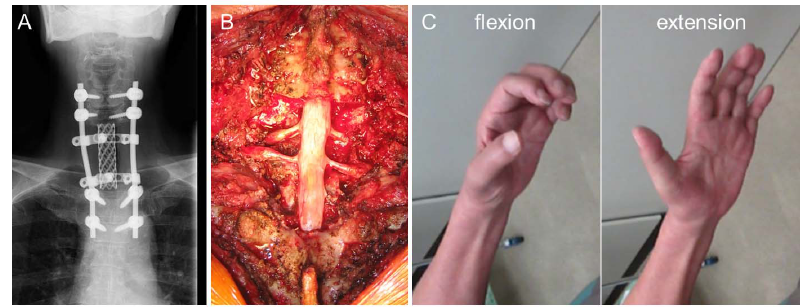
Figure 4. Case 2: A 71-year-old man with metastatic renal cell carcinoma at C7–T2. A: Total en bloc spondylectomy (TES) was performed using a combined anterior and posterior approach. B: Bilateral T2 nerve roots ware transected and bilateral C8–T1 nerve roots ware circumferentially dissected to the extraforamen. C: Severe upper-extremity motor dysfunction persisted even 3 years after surgery.